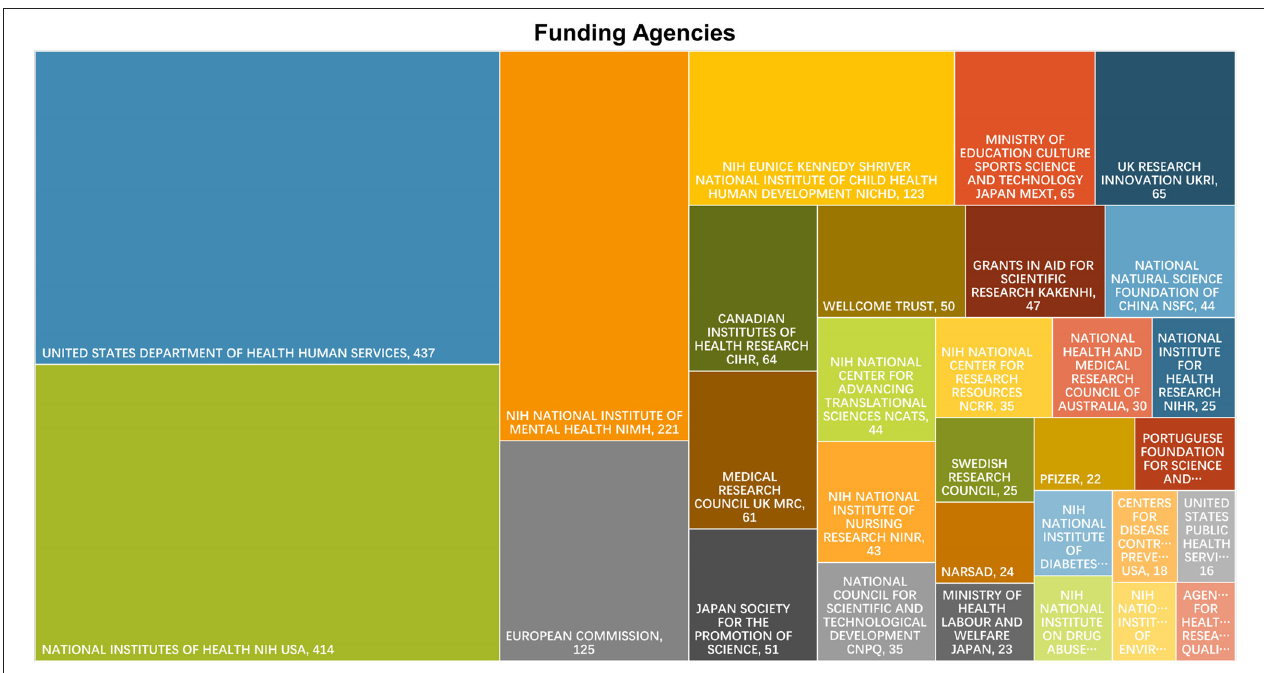
FIGURE 3 | The Tree-map Visualization of funding agencies for literature on